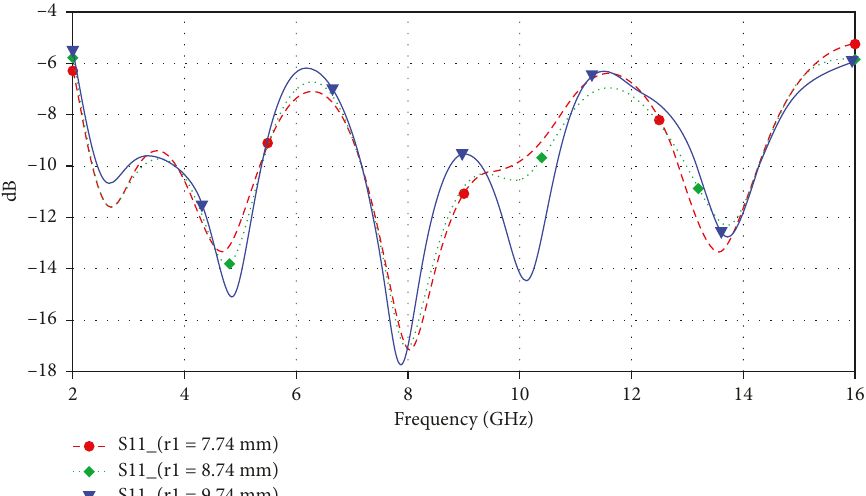
Figure 5: Parametric analysis-radius of the ring slot r 1.